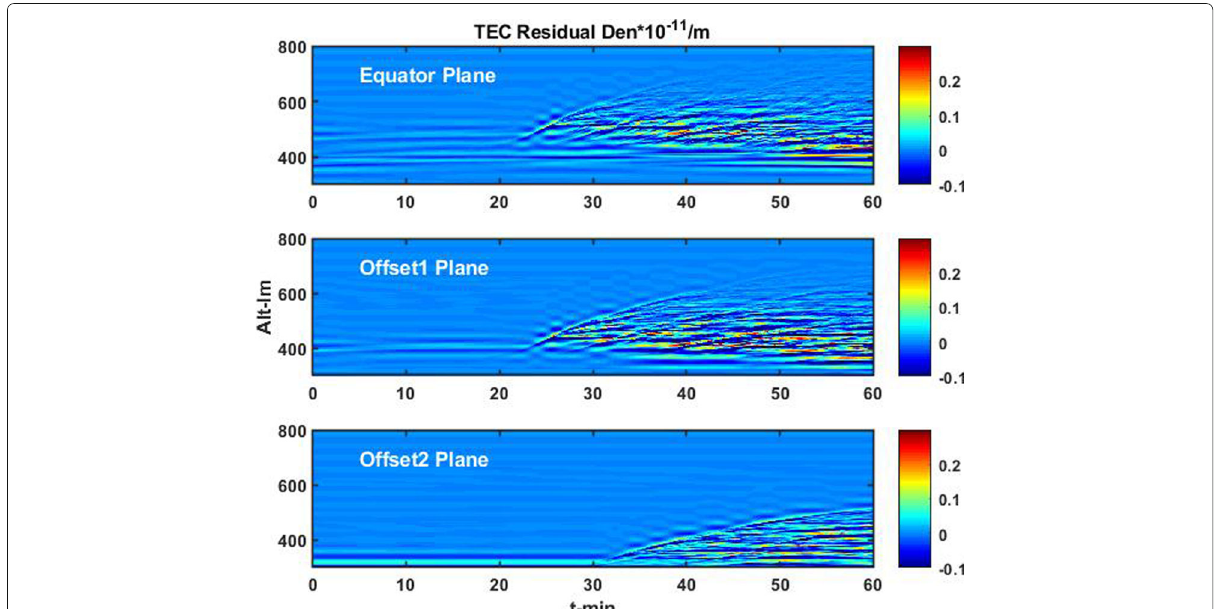
Fig. 6 Evolution of height-dependent residual structure at 100 s for equatorial, offset1, and offset 2 slices